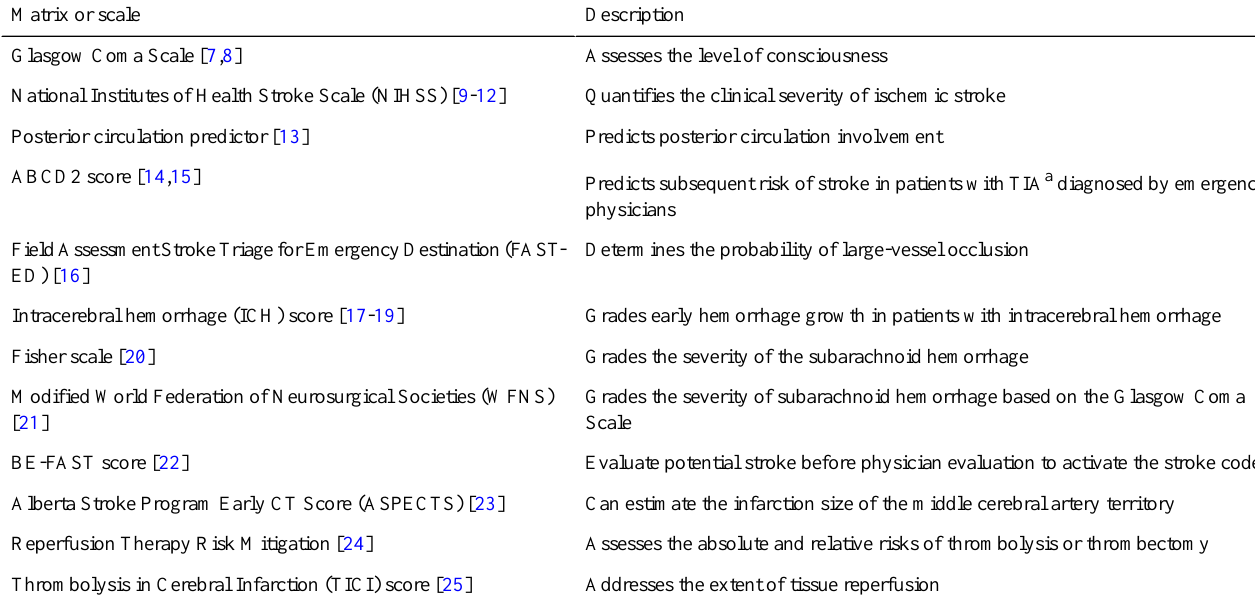
Table 1. Neurological and radiological scales used in the stroke treatment processes. DescriptionMatrix or